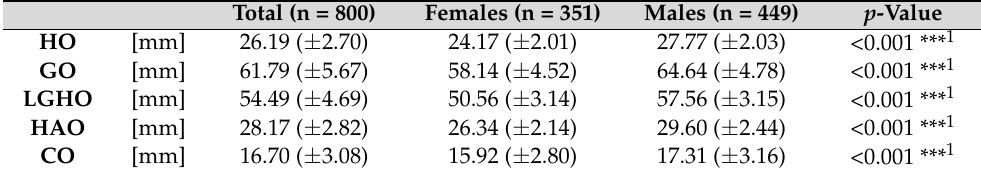
Table 3. Analysis of gender-specific differences between offset parameters.